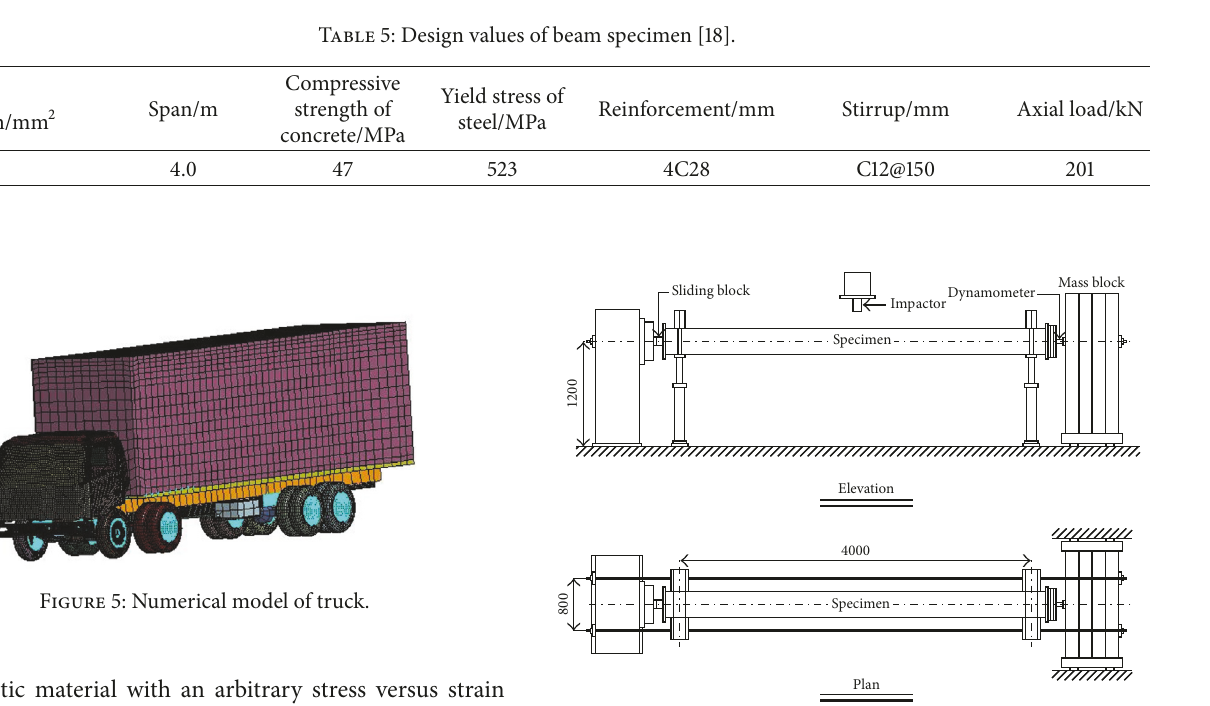
Figure 6: Drop hammer impact test [18].